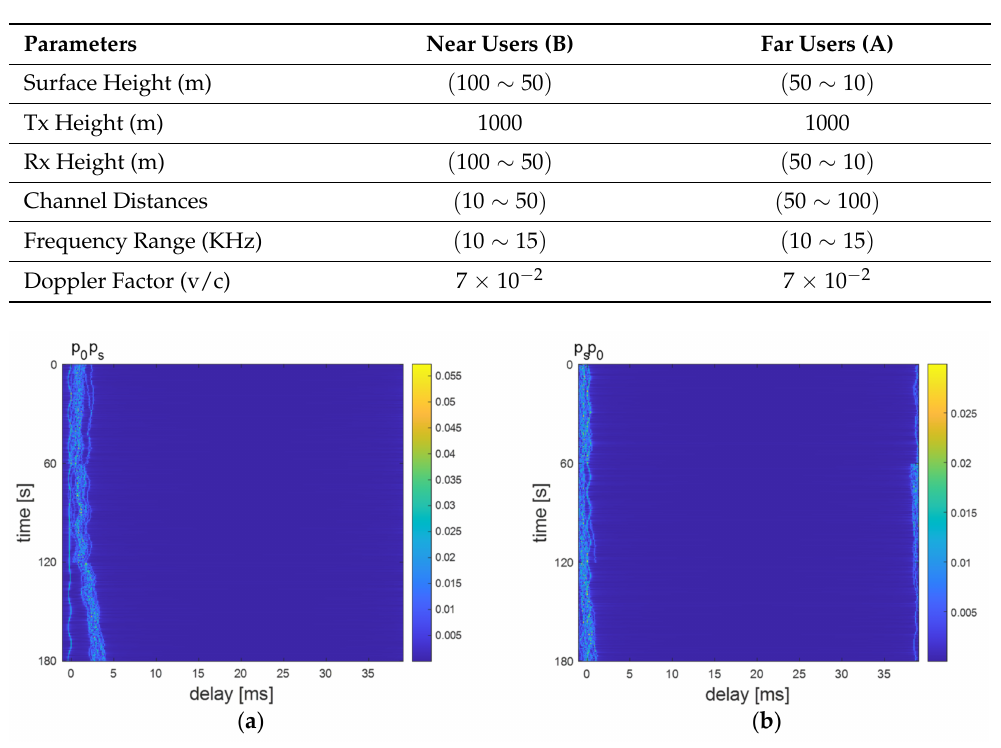
Table 2. Parameters of the UWA channel model.